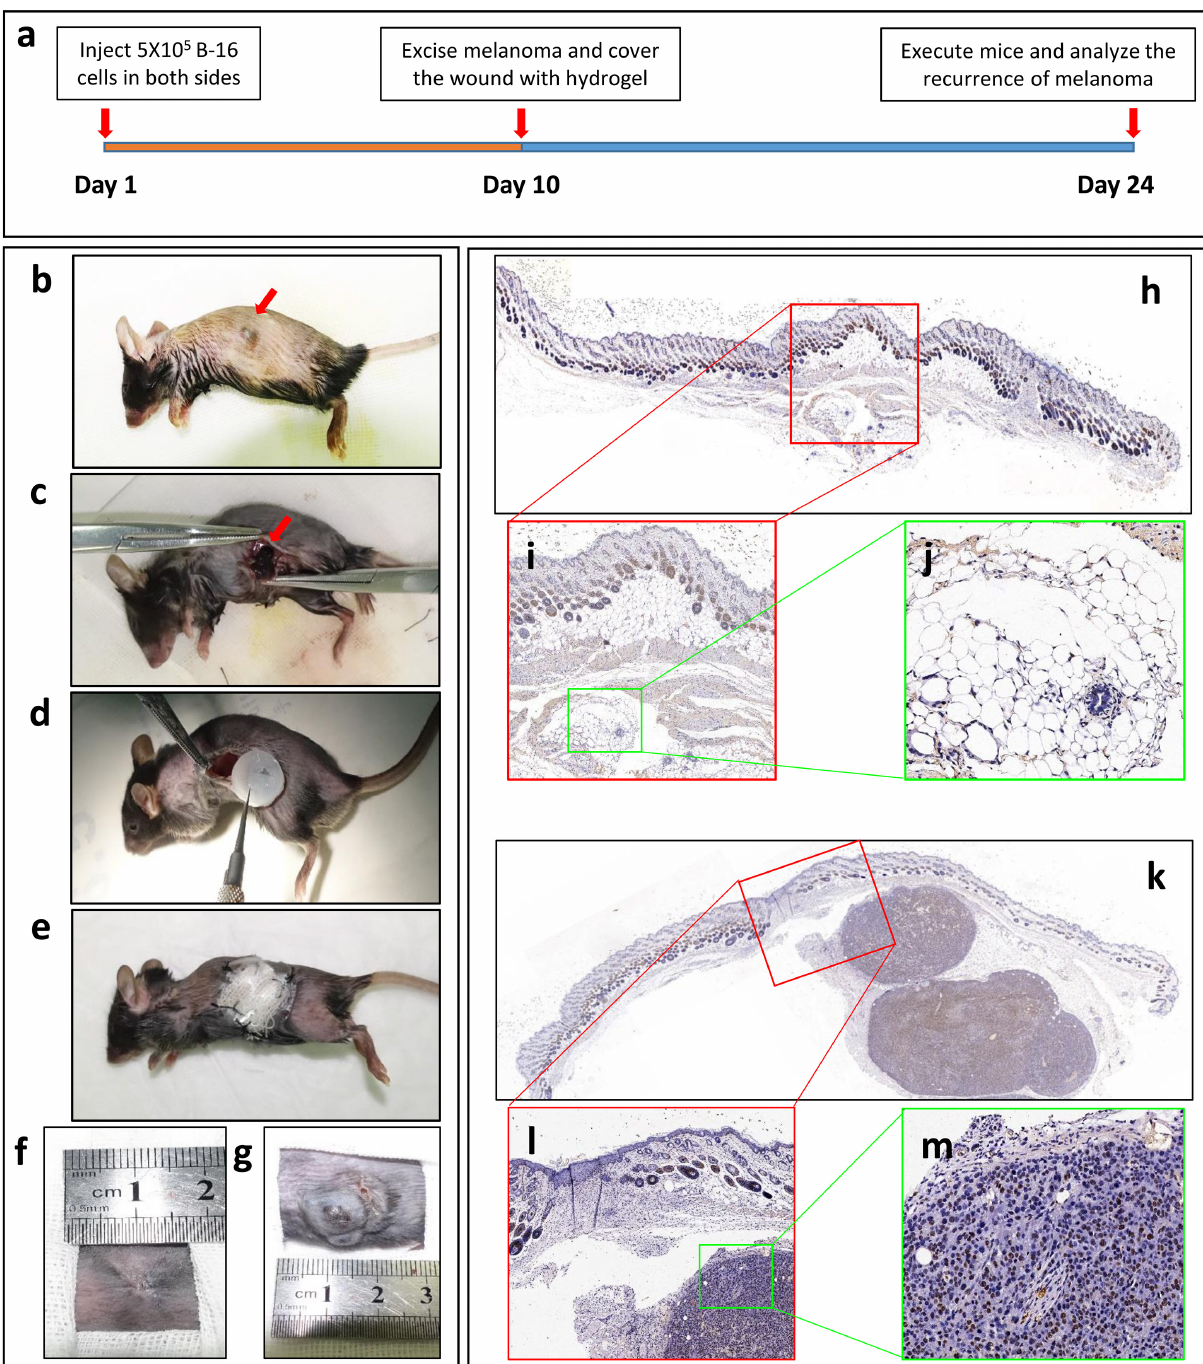
Figure 5: The Yb 3+ -containing hydrogel inhibits melanoma progression in mouse models. (a) The procedure of the mouse experiment. (b-e) Melanoma cells were injected into both sides of the abdomen in subcutaneous tissues in SD mice. The xenografts were observed approx- imately 10 days later (b). Both sides of the tumor were incompletely resected (c), and the wounds were covered with an Yb 3+ -containing hydrogel or a blank hydrogel (d). The wounds were sutured, and the open area remained covered with gauze and a plastic protector (e). The gauze and plastic protector were removed, and the wounds covered with the Yb 3+ -containing hydrogel (f) and the blank hydrogel (g) were analyzed after 2 weeks to detect the recurrence of melanoma. IHC of ki-67 was carried out on the skin tissues, including the implanted hydrogel (h-j) and relapsed melanoma tissue